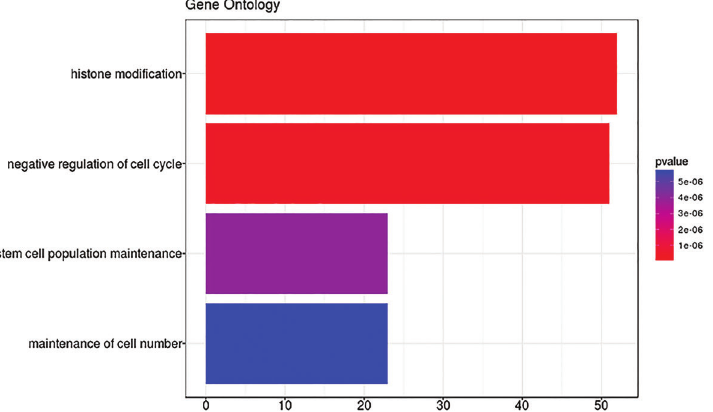
Figure 5. Signi fi cant gene oncology terms based on false discovery rate o